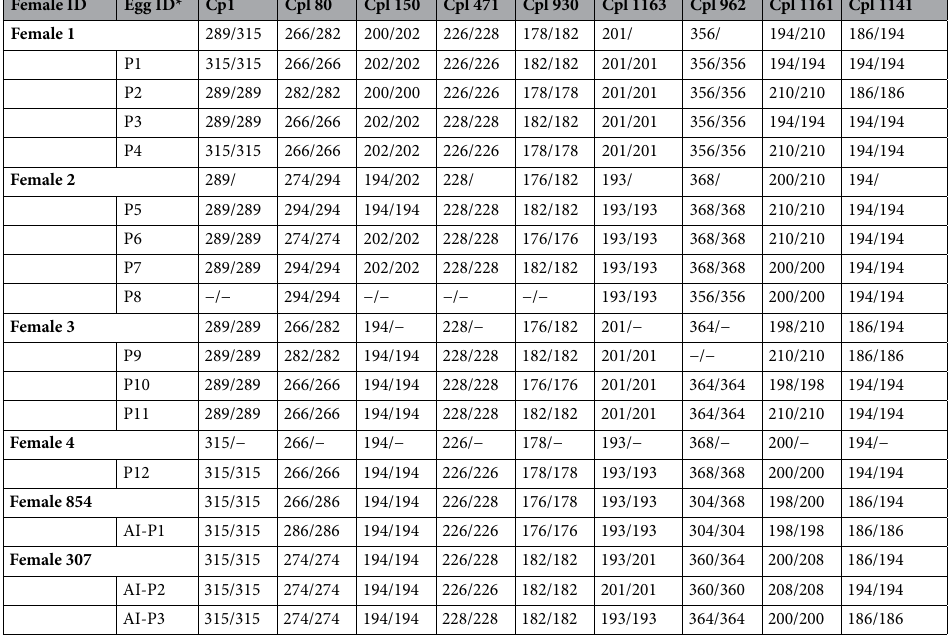
Table 4. Whitespotted bamboo shark Chiloscyllium plagiosum female and parthenote microsatellite loci. *P1– P12 eggs were laid by females housed without males and not inseminated, AI-P eggs were laid by inseminated females; – Indicates failed loci; missing data represent loci that could not be determined by genotype